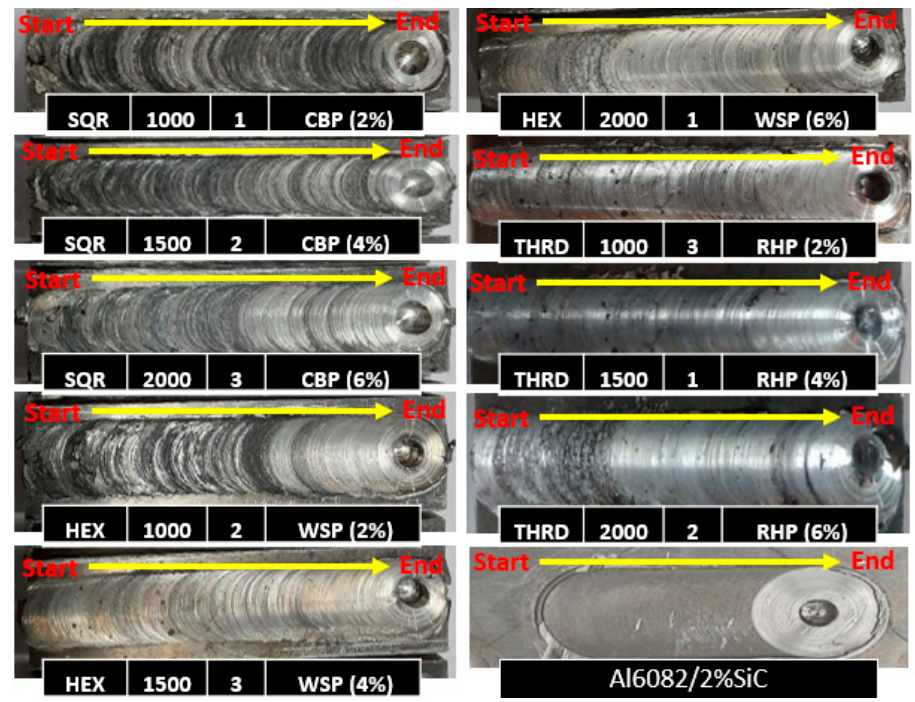
Figure 3. FSP operation at different process parameters based on L 9 Orthogonal Array.